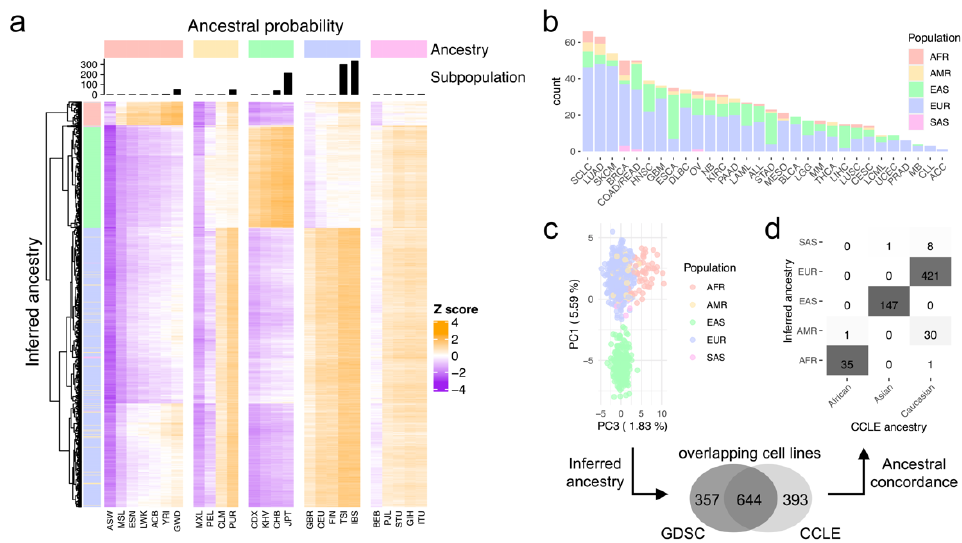
Figure 2. Inference of the ancestral distribution in cancer cell lines. ( a ) Heatmap of the z -scores for the inference of ancestry by estimating ancestral probabilities using a Bayesian method. ( b ) Distribution of inferred ancestries across cancer types. ( c ) PCA on the ancestral genotyping matrix. ( d ) Ancestral concordance between inferred ancestries of the GDSC and annotated CCLE CCLs.